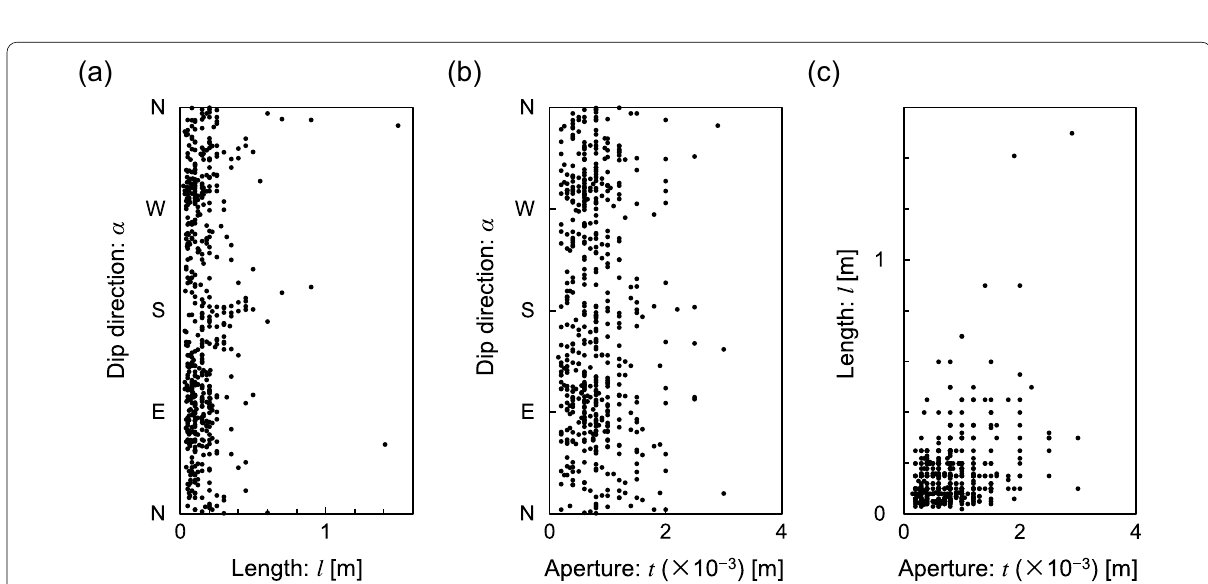
Fig. 6 Data for quartz veins with Chi-square test as statistical analysis. a Relationship between dip directions and length of veins. b Relationship between dip directions and aperture of veins. c The horizontal axis of the graph is apertures and the vertical axis is lengths of